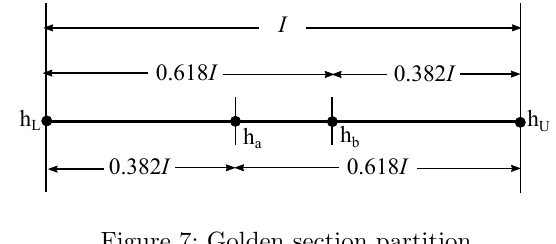
Figure 7: Golden section